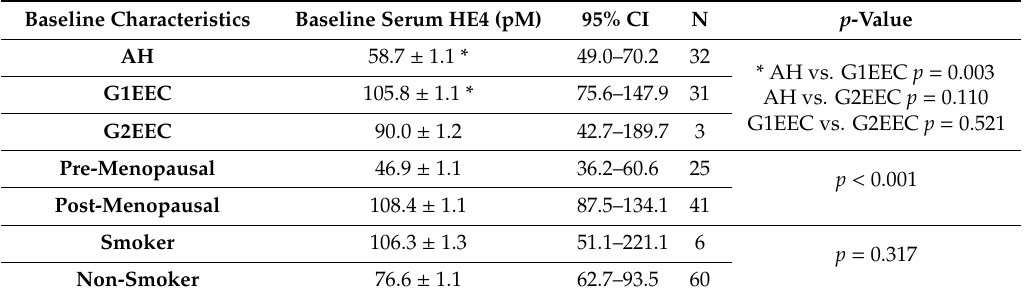
Table 2. Mean baseline serum human epididymis protein 4 (HE4) according to histology, menopause and smoking status (n = 66) (* p <